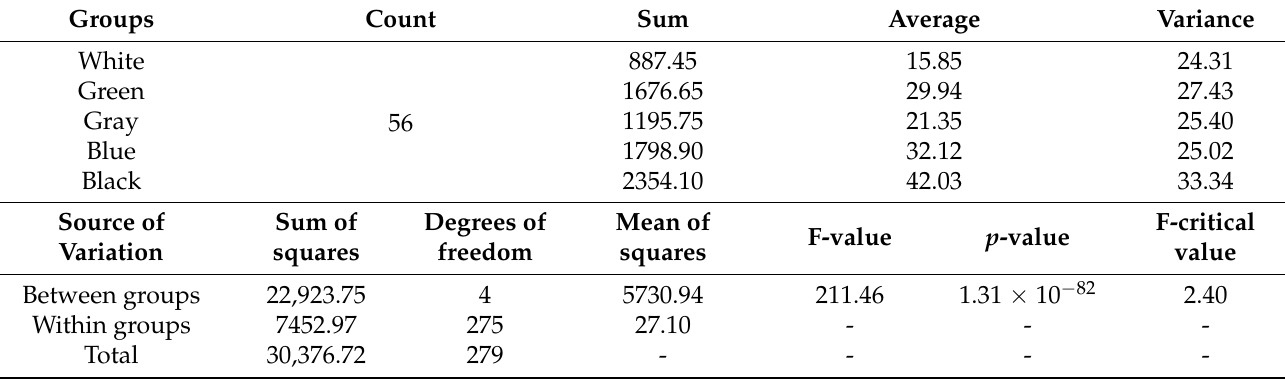
Table 7. ANOVA test for the comparison of surface temperature differences between colored roofs.